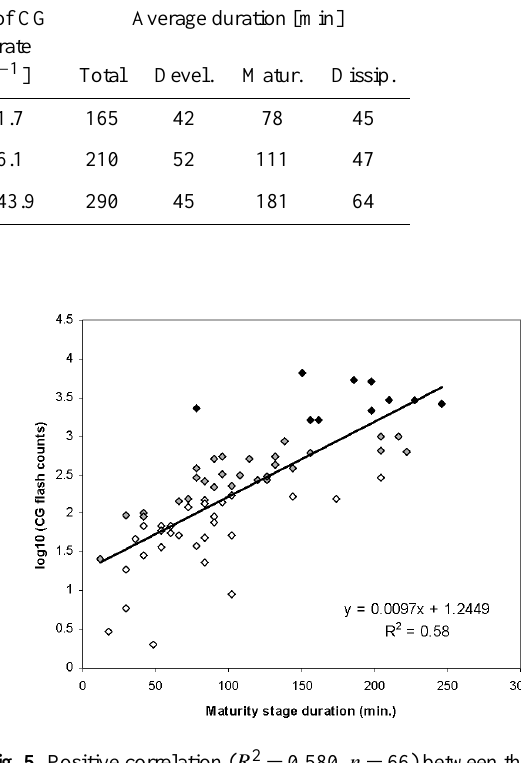
Fig. 5. Positive correlation ( R 2 = 0 . 580, n = 66) between the dura- tion of the maturity stage and the logarithm of the CG flash counts observed during the same phase. Colours correspond to the inten- sity categories: weak (white), moderate (grey) and strong